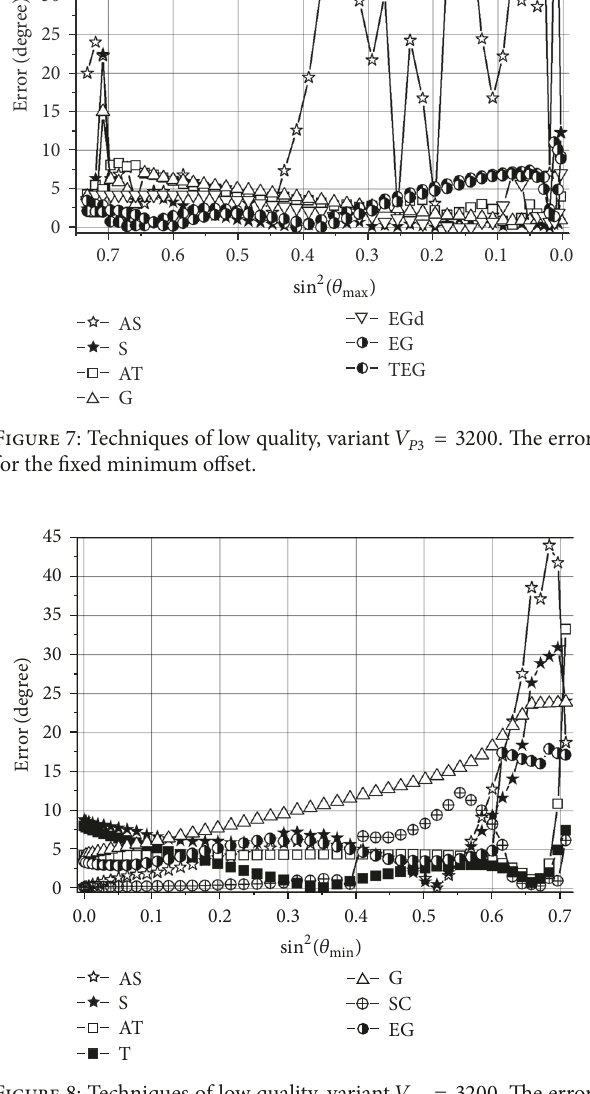
Figure 8: Techniques of low quality, variant 𝑉 𝑃3 = 3200 . The error for the fixed maximum offset.